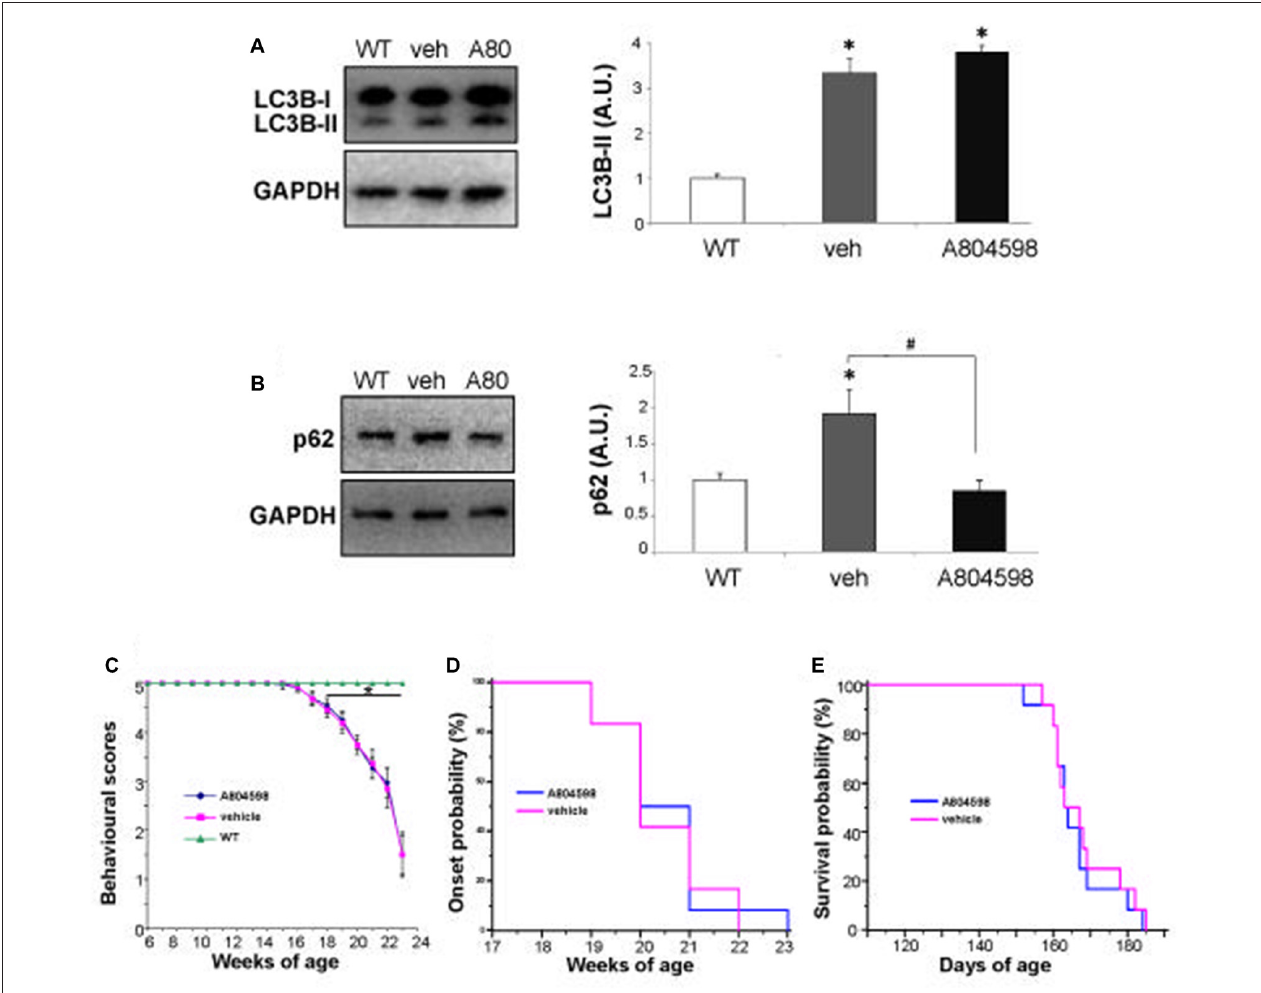
FIGURE 5 | In vivo chronic treatment with P2X7 antagonist A-804598 decreases SQSTM1/p62 expression in lumbar spinal cord of SOD1-G93A mice. Equal amounts of protein from lumbar spinal cord lysates of WT mice ( ∼ 5 months) and vehicle- or A-804598-treated SOD1-G93A mice at end stage ( n = 4/group) were subjected to western blotting with anti-LC3B-II (A) , anti-SQSTM1/p62 (B) and anti-GAPDH. (C) Behavioral scores are not affected by A-804598 treatment ( n = 12) with respect to vehicle mice ( n = 12). WT mice ( n = 3). Data represent mean ± SEM. Statistical significance was calculated by student’s t -test or ANOVA followed by Post Hoc Tukey’s test referred to WT ( A–C ; ∗ p < 0.05) or to vehicle mice ( B ; # p < 0.05). (D) The disease onset of SOD1-G93A mice, as shown by Kaplan–Meier survival curves was not affected by A-804598. (E) A-804598-treated mice show no significant differences in median survival with respect to